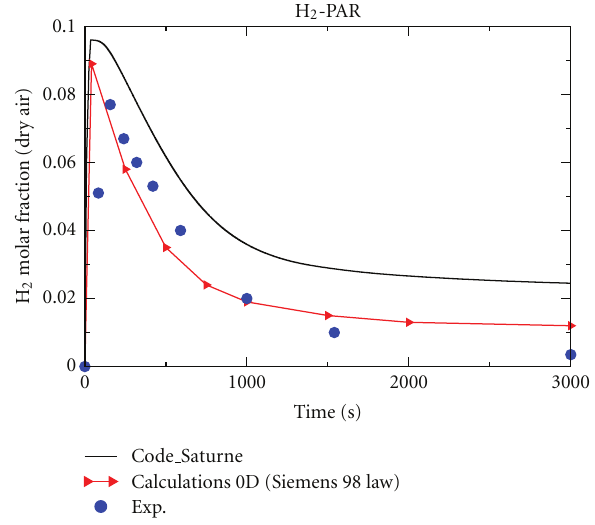
Figure 5: E2bis test—time evolution of hydrogen molar